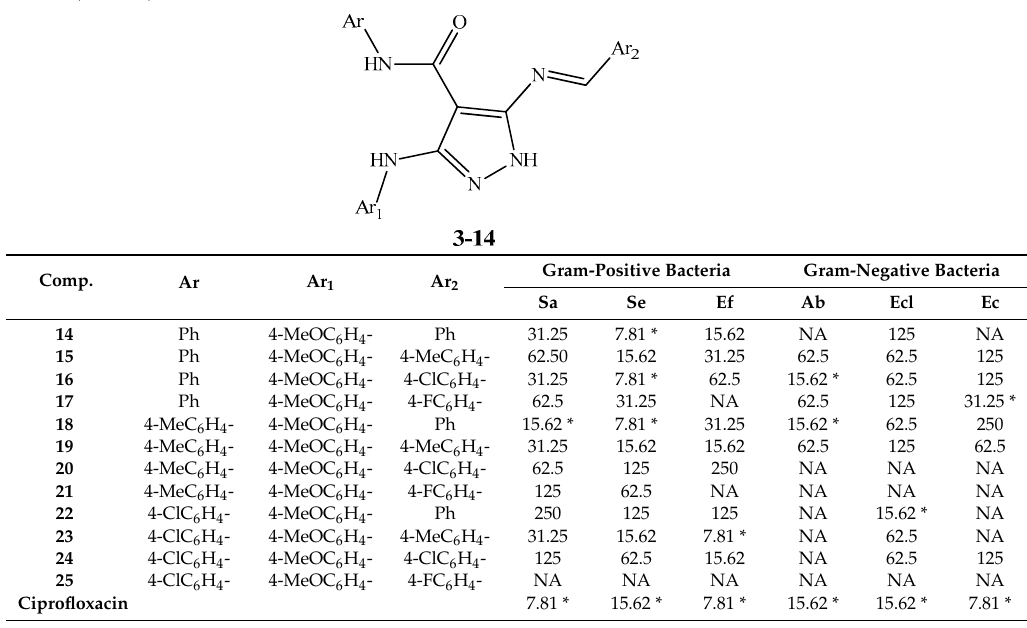
Table 2. Minimal inhibitory concentrations in µg/mL of Schiff bases against multi-drug resistant bacteria (MDRB).